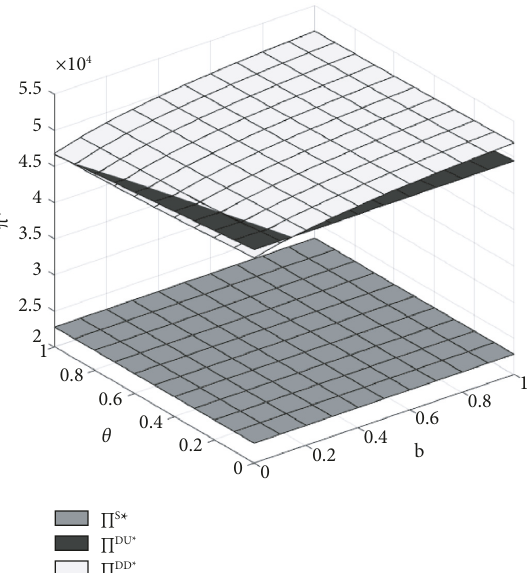
Figure 6: Comparison of optimal supply chain’s profits among three